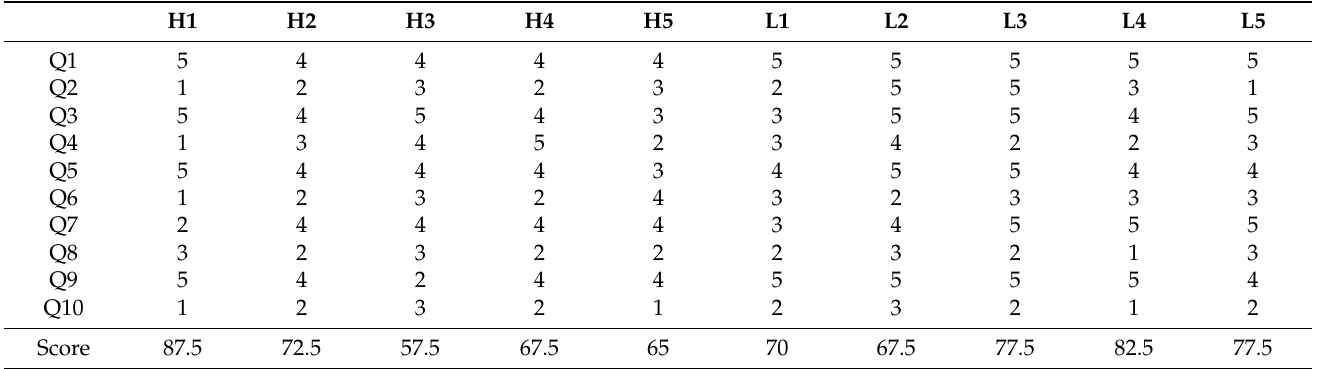
Table 2. Responses to individual SUS items for the two considered groups with high/medium or low skills in